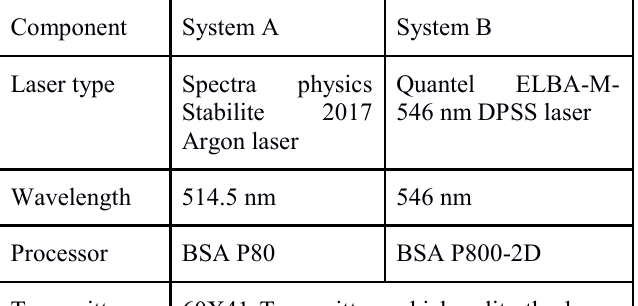
Table 1. Parameters of the PDA systems .